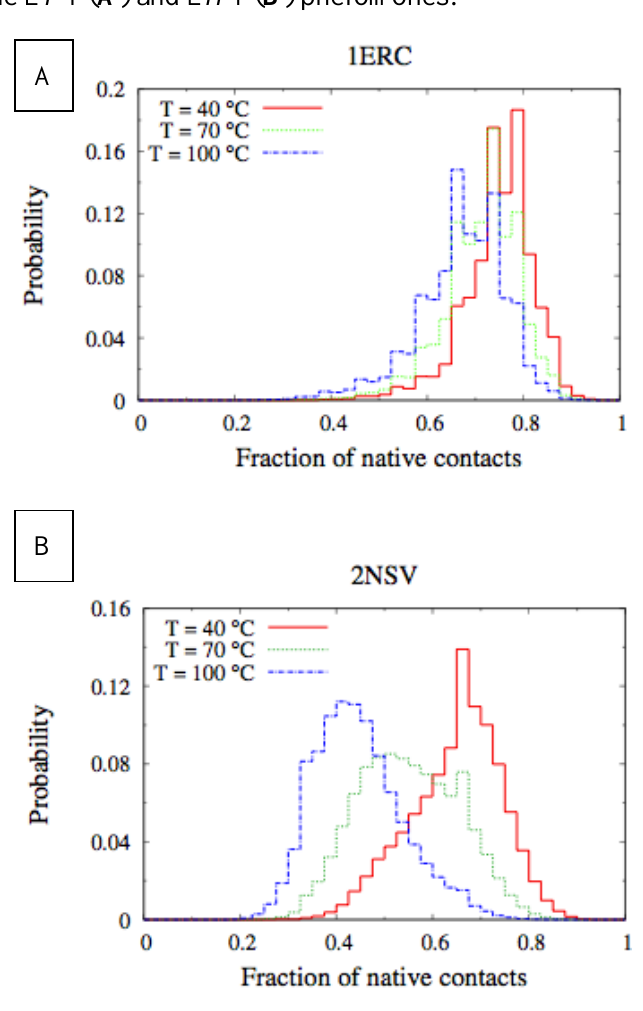
Figure 6. Equilibrium distributions of the fraction of native contacts at different temperatures for the E r -1 ( A ) and E n -1 ( B ) pheromones.